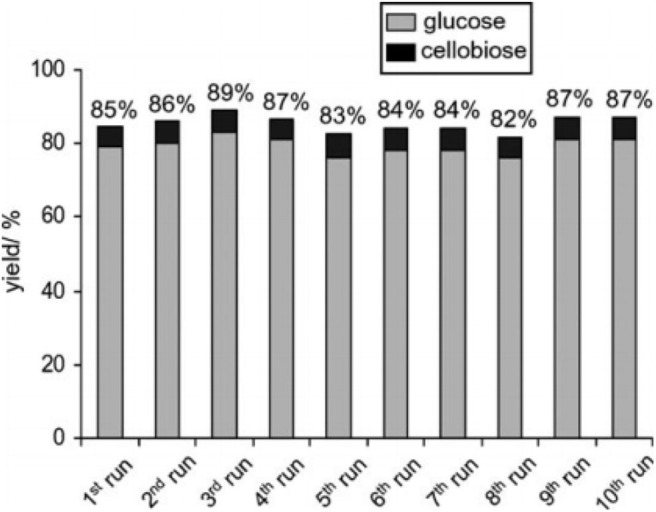
Recyclability of H5BW12O40 for the conversion of pretreated cellulose. Reaction conditions: 100 mg pretreated cellulose (the cellulose was mercerized and then ball-milled), 0.70 mol/L, 2 mL H5BW12O40 solution, 60°C for 24 h. Reproduced with permission from Ogasawara et al. (2011).